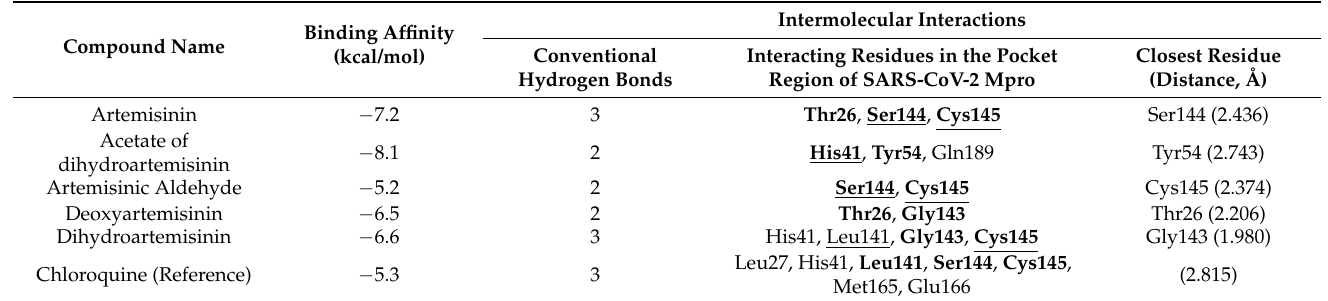
Table 2. Binding affinity, conventional hydrogen bonds and interacting residues of the main Artemisia campestris docked compounds into the SARS-CoV-2 Mpro (6LU7).